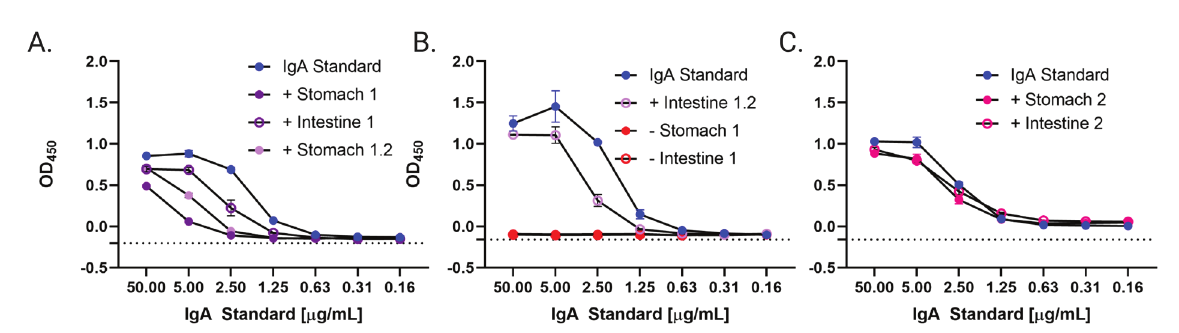
Supplementary Figure 7. Stomach and Intestinal Homogenates from Neonatal Mice Contain human IgA. Stomach and intestinal homogenates from pups suckled on ZAC-3 hIgA+ and hIgA- dams were an- alyzed by human IgA sandwich ELISA. Samples from a total of four pups were analyzed. A mouse suckled on an hIgA- dams (panel A, red symbols), two littermates (mice 1.1, 1.2) from a single hIgA+ dam (panels A, B) and a single mouse from a second litter (2.1; panel C). Human colostral IgA was used as a standard. mice Data are comprised of 1 biological replicate and 2 technical replicates.